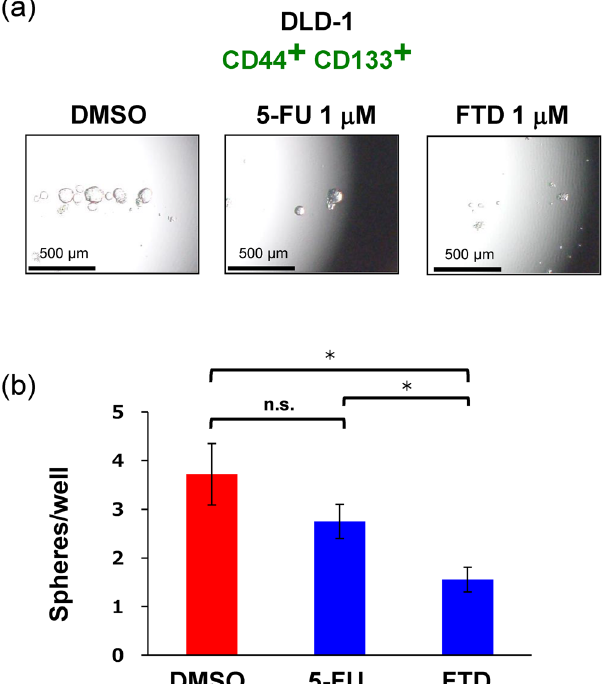
Figure 3. FTD efficacy toward sphere-forming activity of CD44 + CD133 + cells. Sphere culture was performed using the CD44 + CD133 + population of the DLD-1 cell line. ( a ) Images of cell spheres treated with DMSO (Control), 1 μ M 5-FU, and 1 μ M FTD; ( b ) Respective sphere numbers. Data points represent means ± SD (n = 6); Student’s t -test, * P < 0.05, n.s.: not